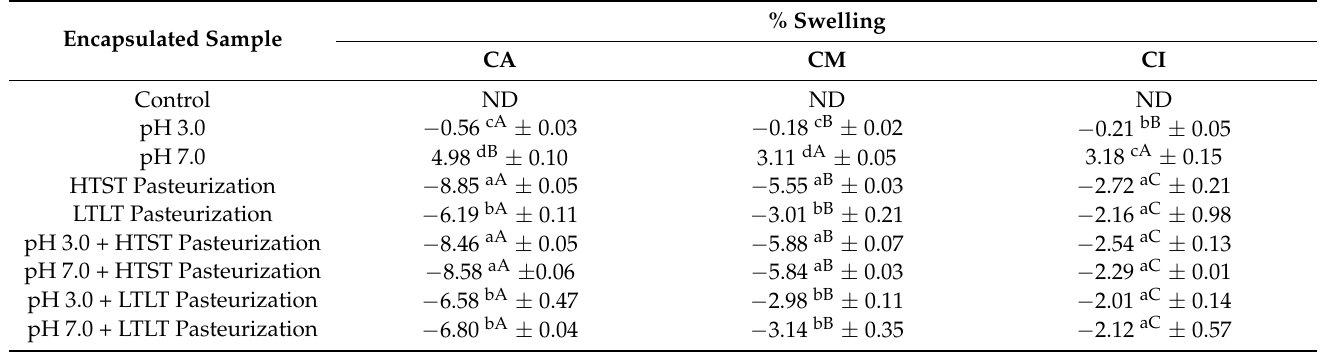
Table 4. Swelling characteristics of alginate (CA), alginate/maltodextrin (CM), and alginate/inulin hydrogel beads contained in encapsulated antioxidant crude extract from